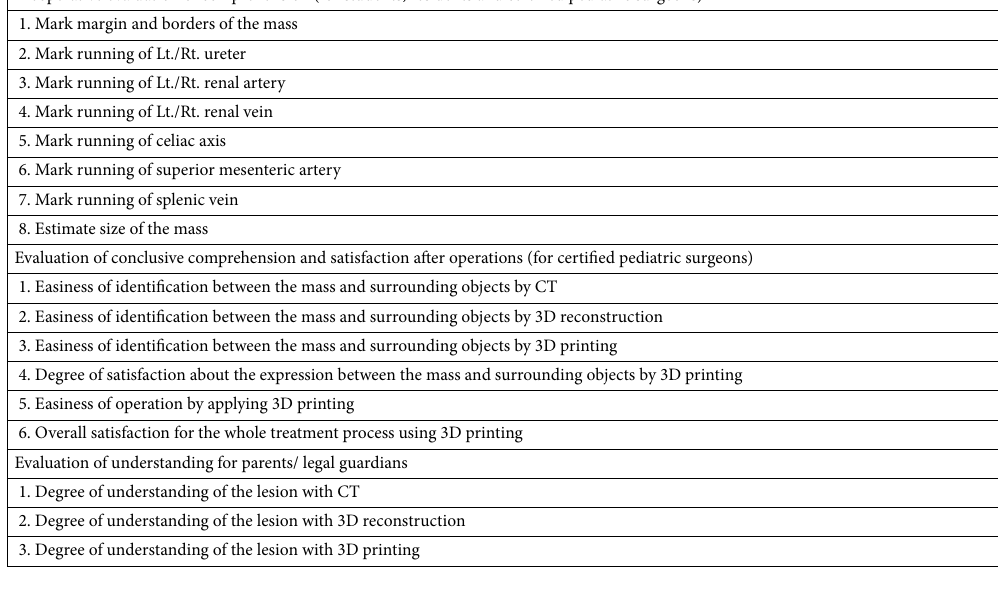
Table 2. Survey items. CT, computed